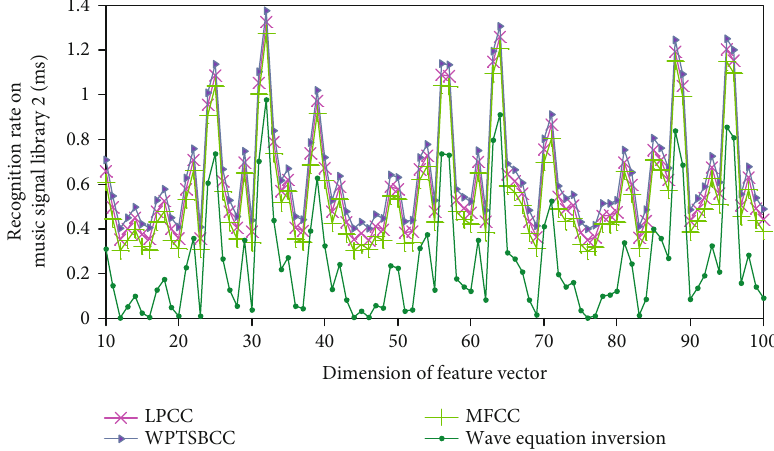
Figure 9: The recognition time of di ff erent feature vector dimensions on the music signal library